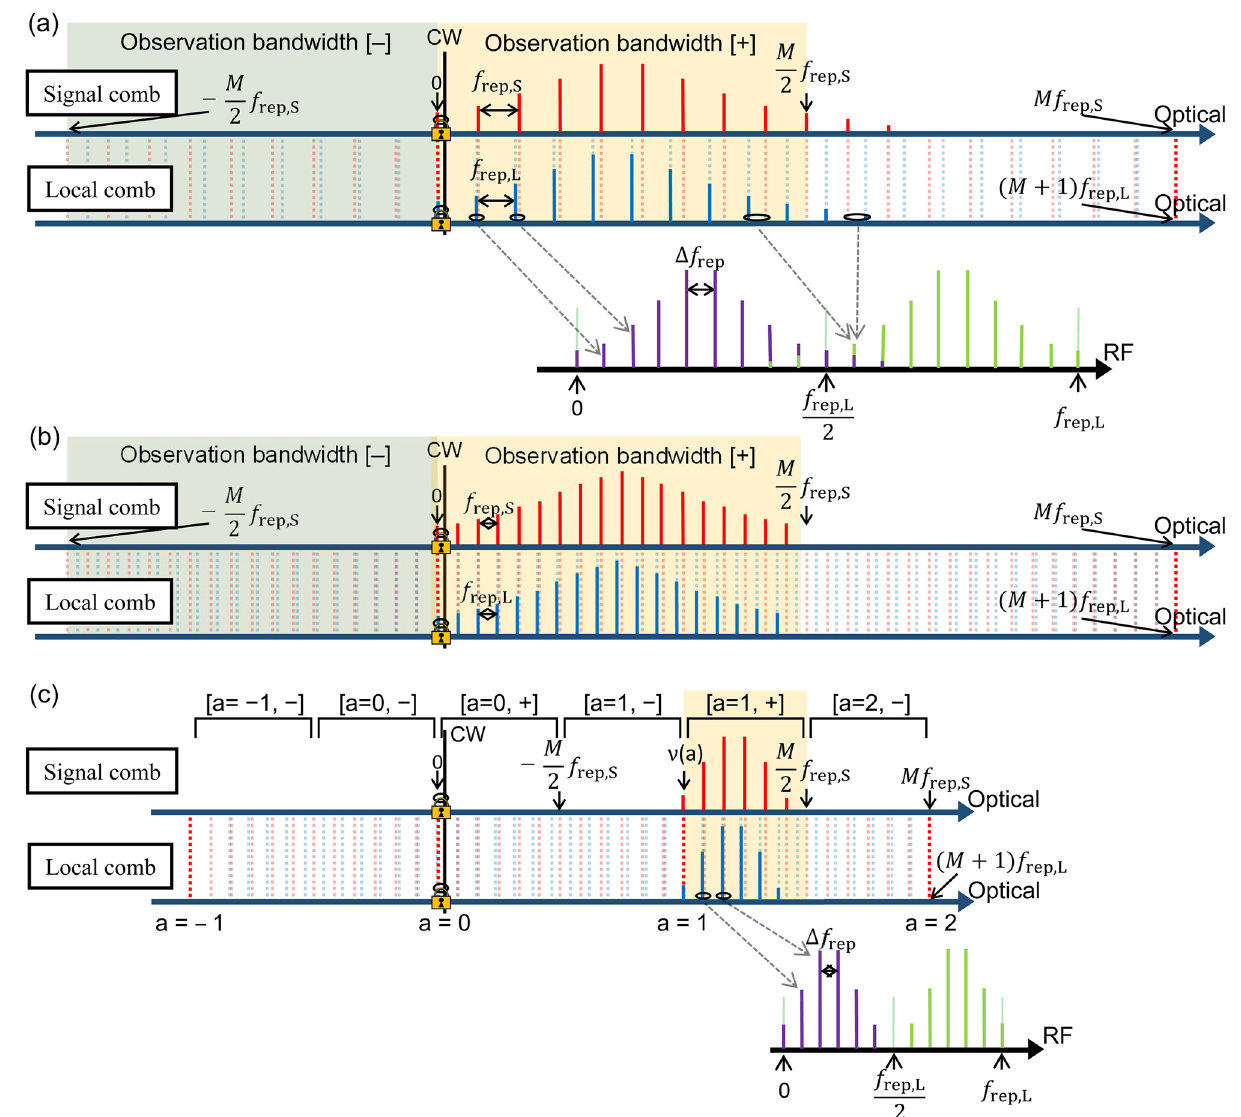
Figure 3. Observation bandwidth and the frequency relationship of the CW laser, signal, and local combs in DCS. ( a ) The observation bandwidth is around the CW laser and the first coincident comb components. The resulting RF comb is also shown with one-to-one correspondence from the signal and local combs. ( b ) The observation bandwidth obtained with low-repetition-rate combs. To achieve the same observation bandwidth as in ( a ), (cid:31) f rep is decreased and M is increased compared to the ( a ) case. ( c ) A method to use the observation bandwidth that is set away from the CW laser and the first frequency coincident components. Using this method, one can set an appropriate observation bandwidth with optimal spectral resolution, (cid:31) f rep , measurement time, and data